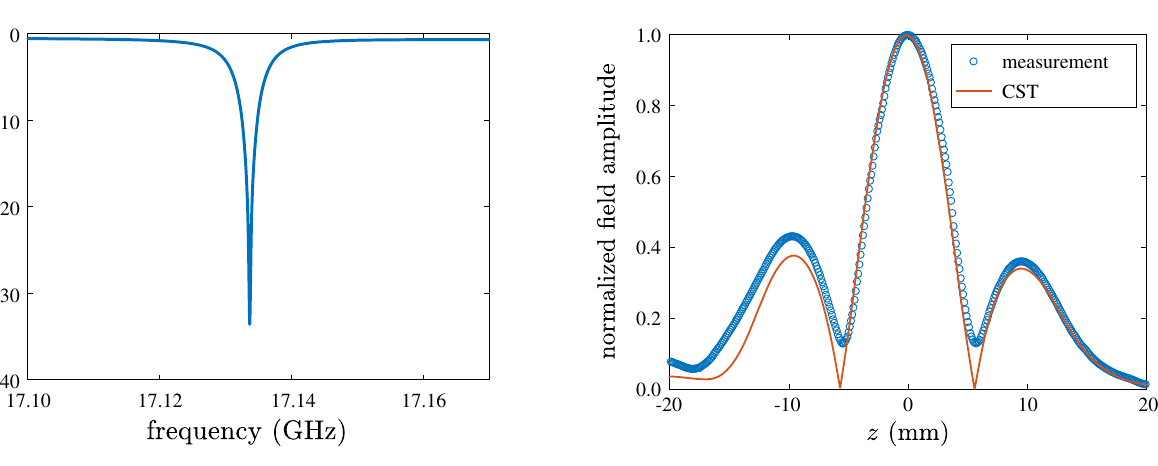
FIG. 10. Reflection coefficient measurement result for the E structure. Critical coupling was achieved for the π mode at 17.134 GHz.